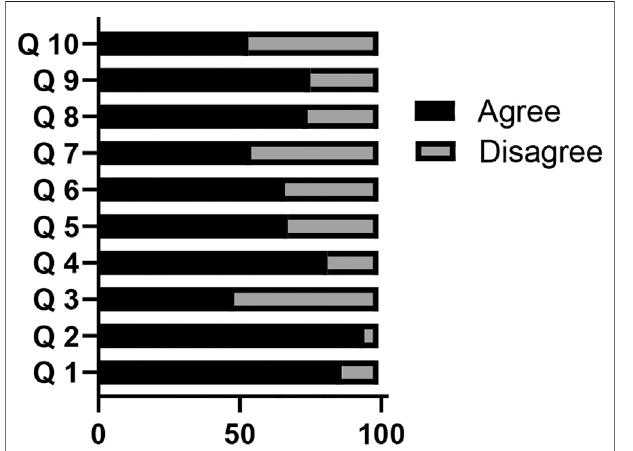
FIGURE 2 | Summary of responses received.